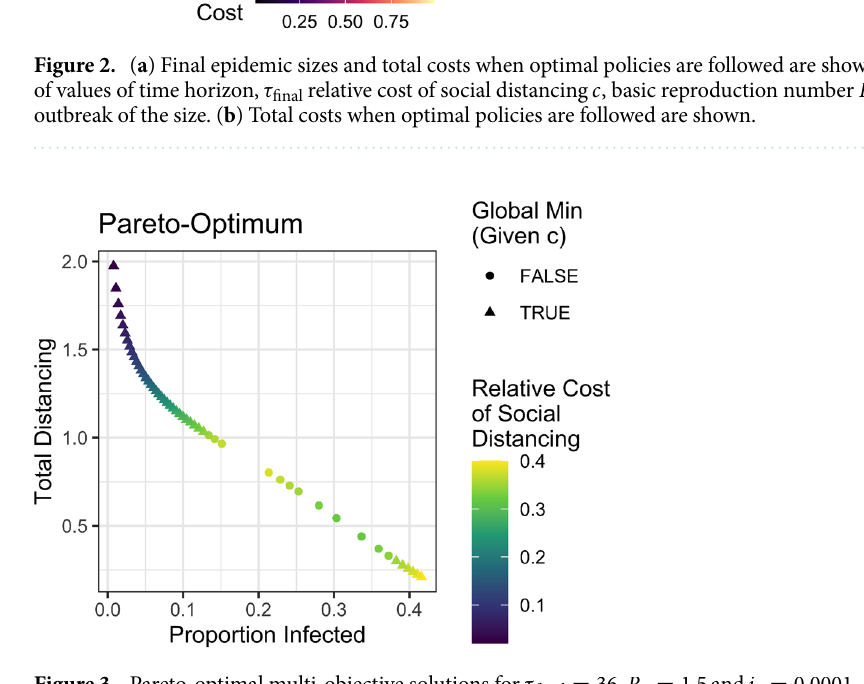
Figure 3. Pareto-optimal multi-objective solutions for τ final = 36 , R 0 = 1.5 and i 0 = 0.0001 . All multi-objective solutions are mathematically equivalent to local optima from the single-objective formulation. Triangles are points that are equivalent to global optima and circles are points that are equivalent to solutions that are local minima only (not global minima). The points’ colors show the value of c from the single-objective formulation that the solution is equivalent